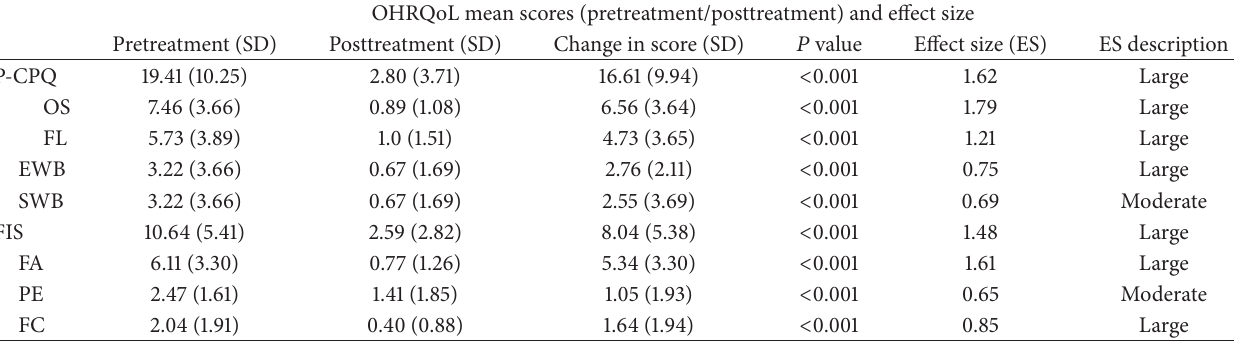
Table 2: Mean overall and domain scores in the Parental-Caregivers Perceptions Questionnaire (P-CPQ) and Family Impact Scale (FIS) at baseline and follow-up, with effect sizes.